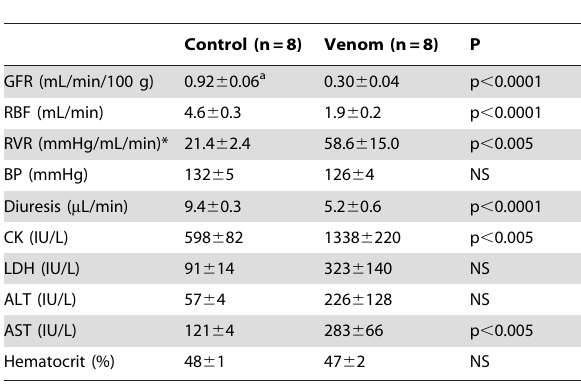
Table 1. Renal and systemic parameters after administration of Loxosceles venom (venom) or saline